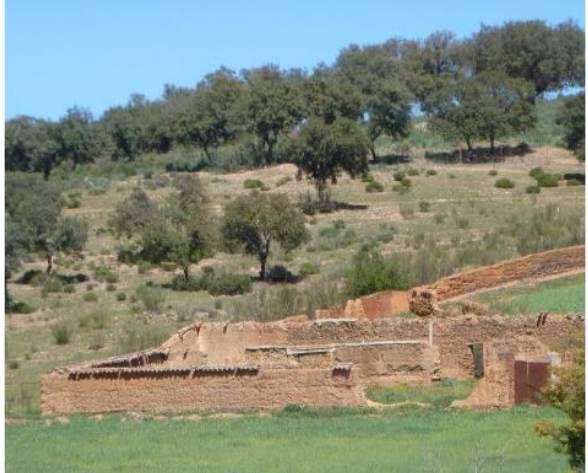
Figure 1. Relationship between the matter from the landscape and the rammed earth walls (Navalpino, Ciudad